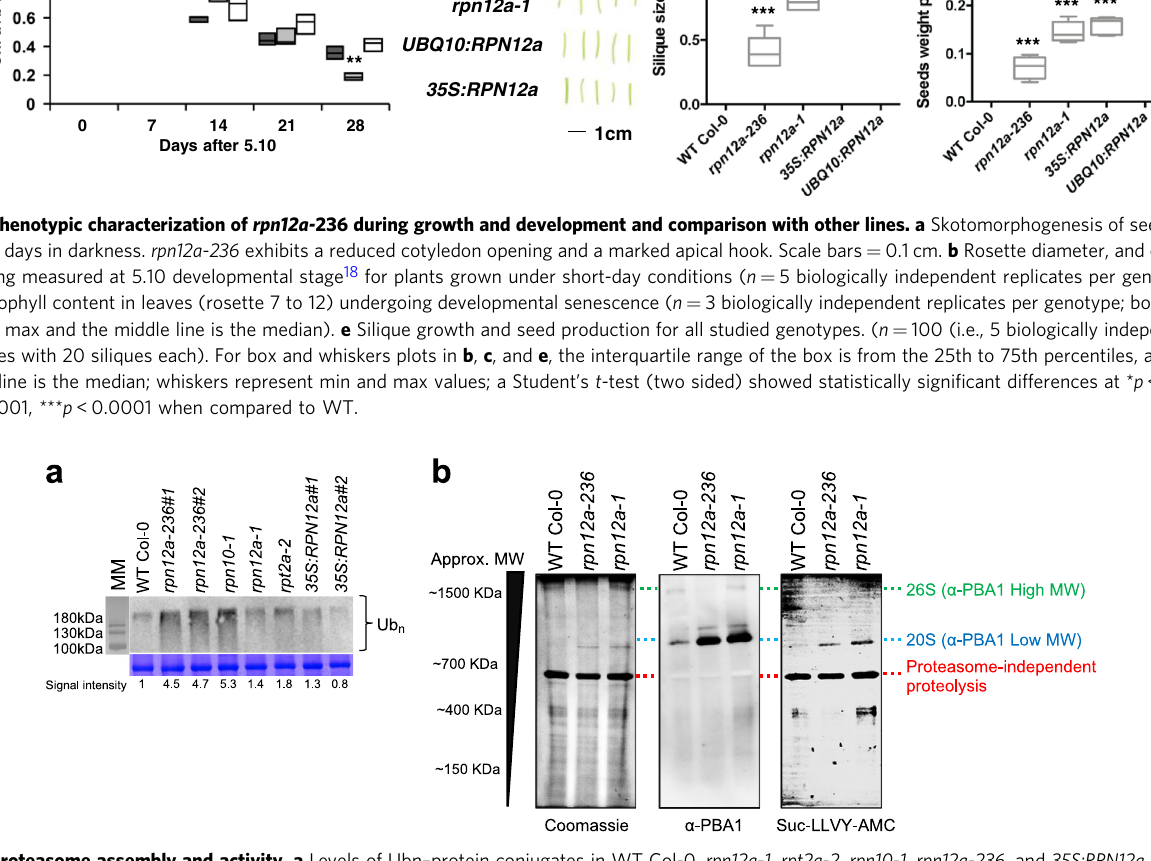
Fig. 3 Proteasome assembly and activity. a Levels of Ubn – protein conjugates in WT Col-0 , rpn12a-1 , rpt2a-2, rpn10-1 , rpn12a-236, and 35S:RPN12a leaves. Twenty micrograms of total protein (control = Coomassie blue staining with a focus on Rubisco large subunit) were subjected to SDS-PAGE and immunoblot analysis with anti-ubiquitin antibodies. The signal intensity of ubiquitin-protein conjugates was estimated, and fold-change as compared to WT Col-0 was reported below the immunoblot for each genotype. b Proteasome chymotrypsin-like activity. Native-PAGE followed by immunoblot analyses of the PBA1 subunit (middle) and activity test (right) in 10 µ g of total protein extracts from 10-day-old seedlings. For the 20S proteasome activity, native- PAGE membrane was incubated with a Suc-LLVY-AMC fl uorophore solution and revealed at 365 nm. Loading control was checked by Coomassie staining (left) (experiments were run in triplicates from independent